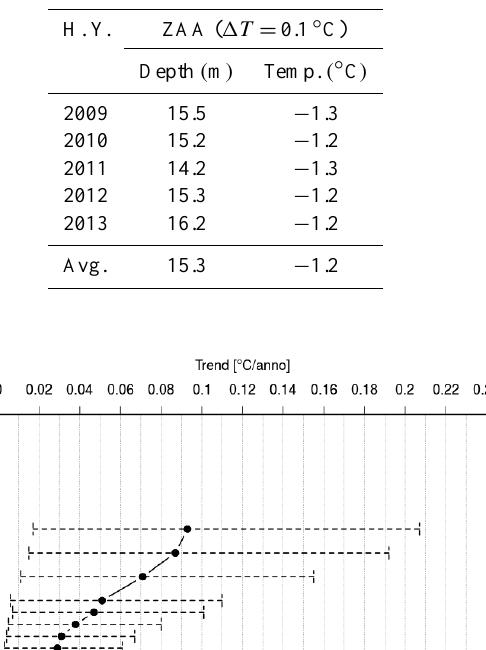
Table 2. Interpolated depth of zero annual amplitude oscillation (ZAA) and corresponding mean temperatures in the borehole DP.